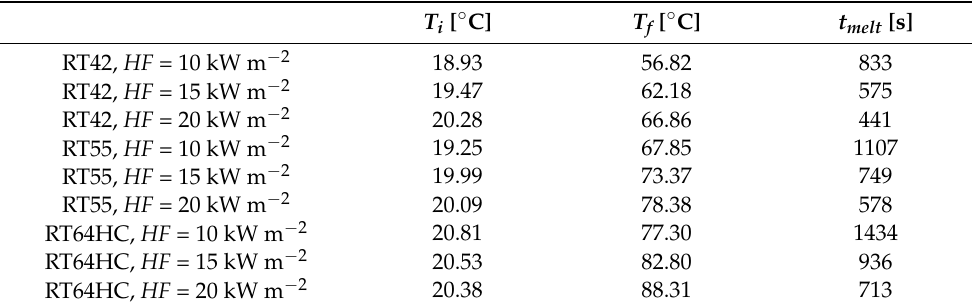
Figure 6. Melting fronts for the paraffin RT42 with an imposed heat flux of 10 kW m − 2 .